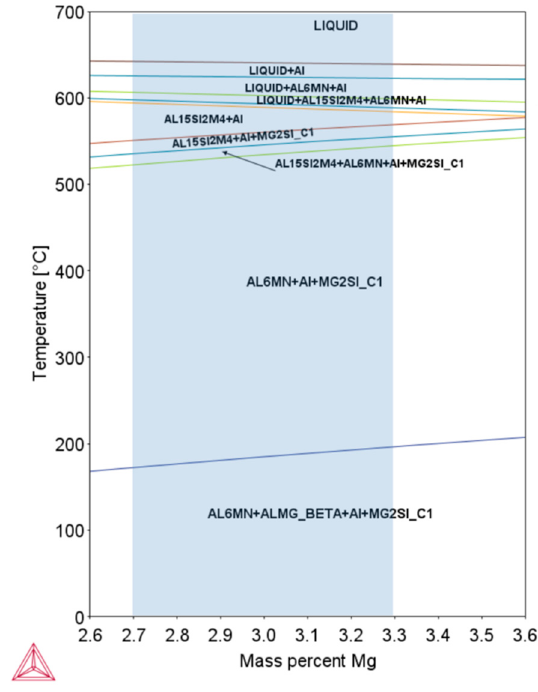
Figure 3. Pseudo—binary phase diagram for 5754 alloy composition.